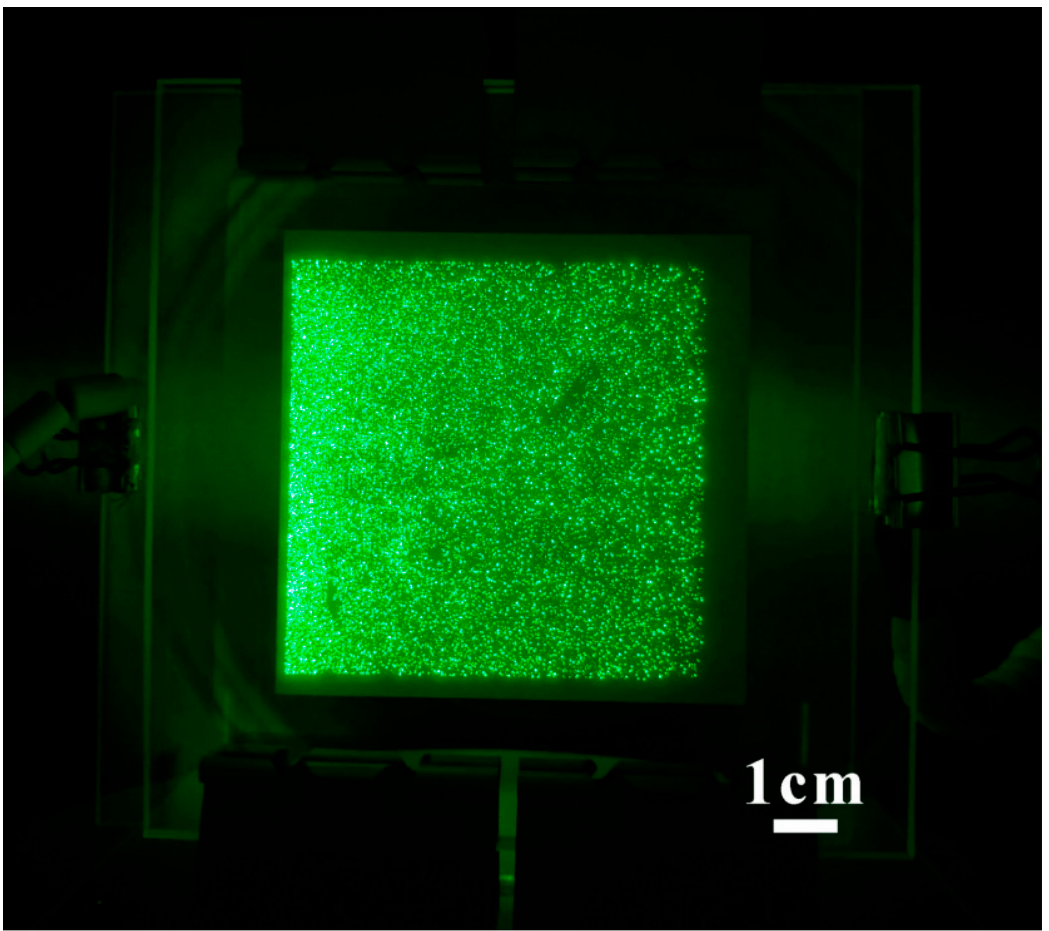
Figure 8. Field emission pattern of a diagonal 4-inch ZnO nanowires array. Reproduced from [61], with the permission of IEEE, 2021.